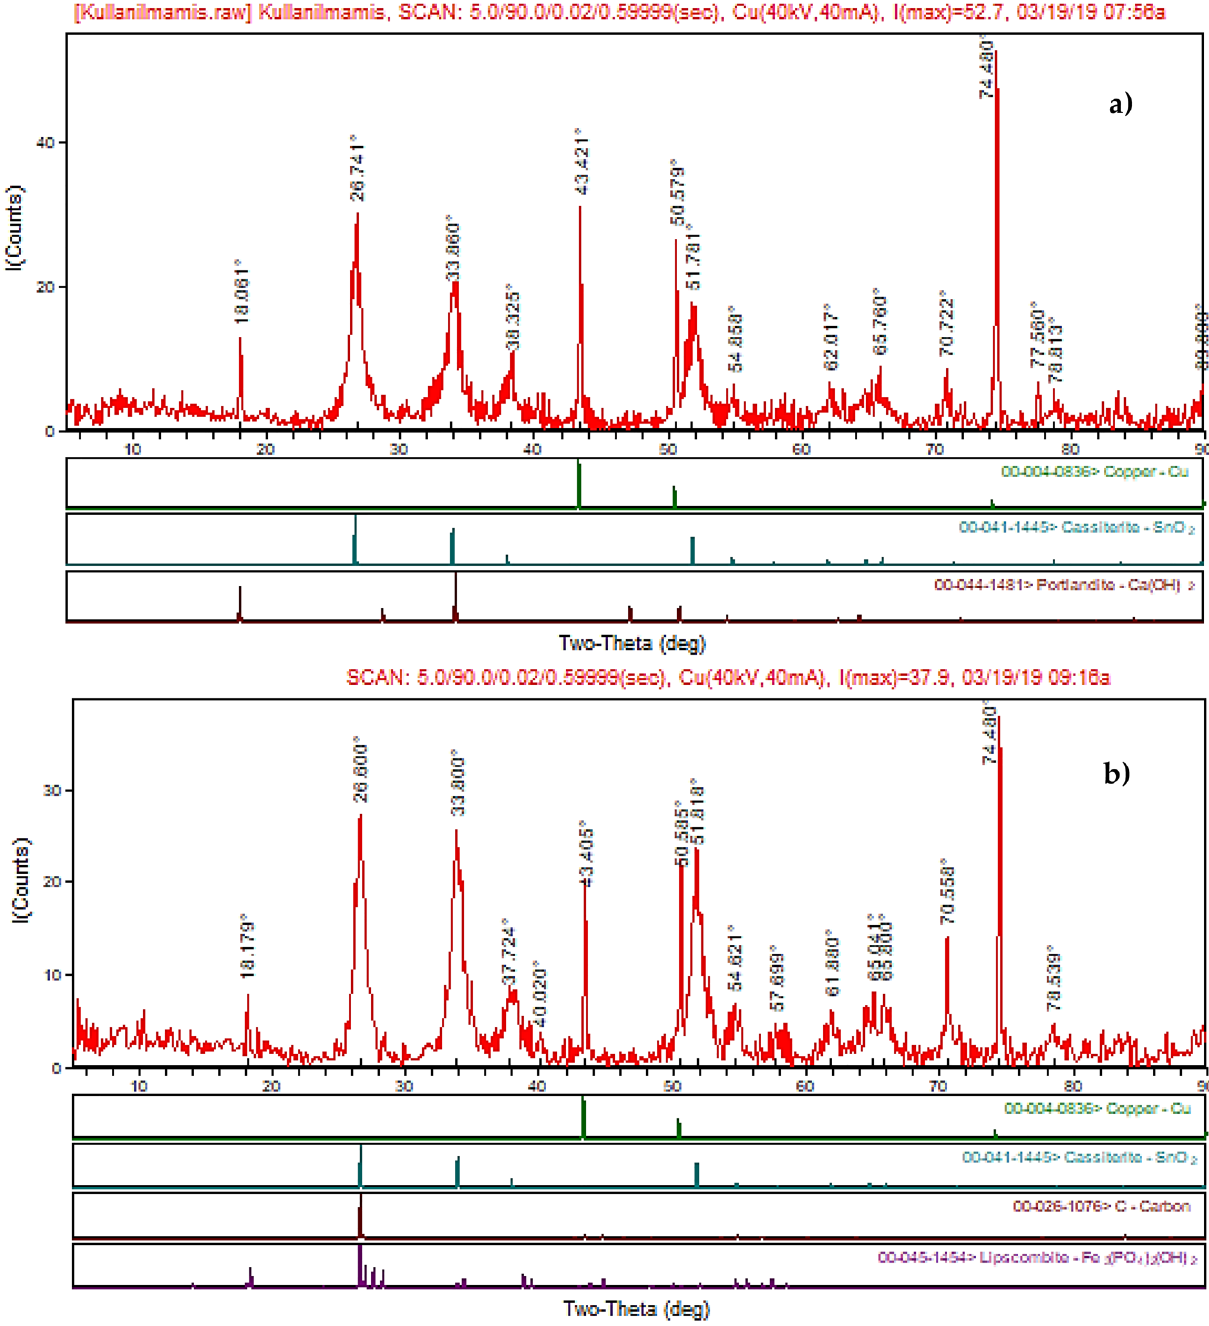
Figure 12. XRD analysis of the anodes ( a ) clean anode and ( b ) contaminated